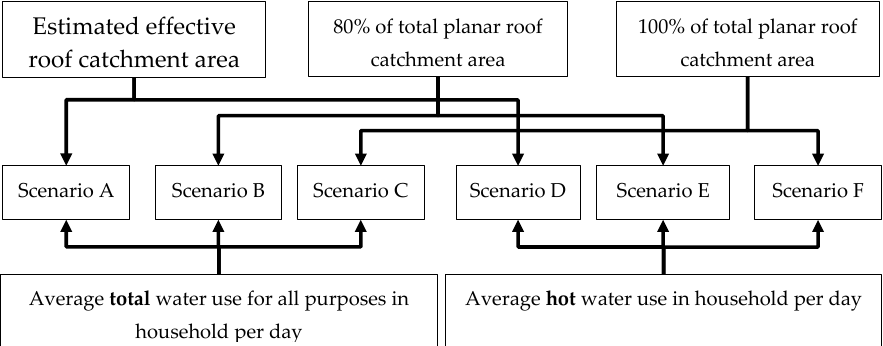
Figure 5. Scenarios for RRHS modelling.